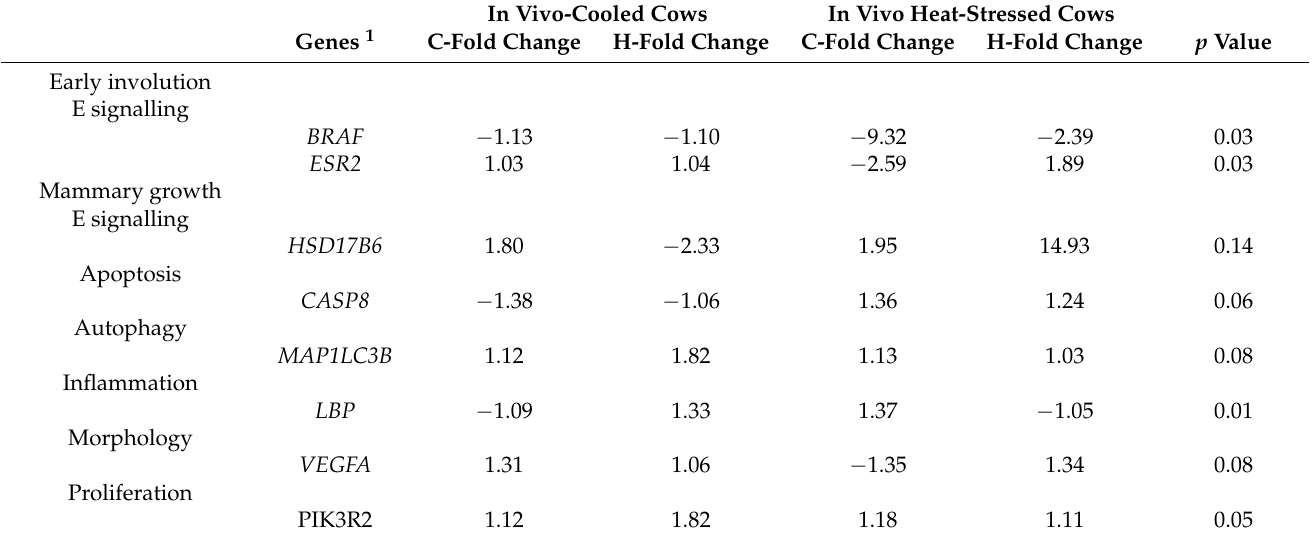
Table 1. Relative gene expression of mammary gland tissue explants collected during involution and mammary redevel- opment of the dry period in cows that were either cooled (shade, fans and soakers) or heat-stressed (only shade). Tissue explants were incubated in vitro in media with different hormone concentrations: Basal media: no prolactin (PRL), no estrogen (E); media C that mimics the hormone combination of cooled cows: Basal + low PRL + high E; media H that mimics hormone combination of heat-stressed cows: Basal + high PRL + low E. Relative gene expression is expressed as a fold change compared with Basal media. In Vivo-Cooled